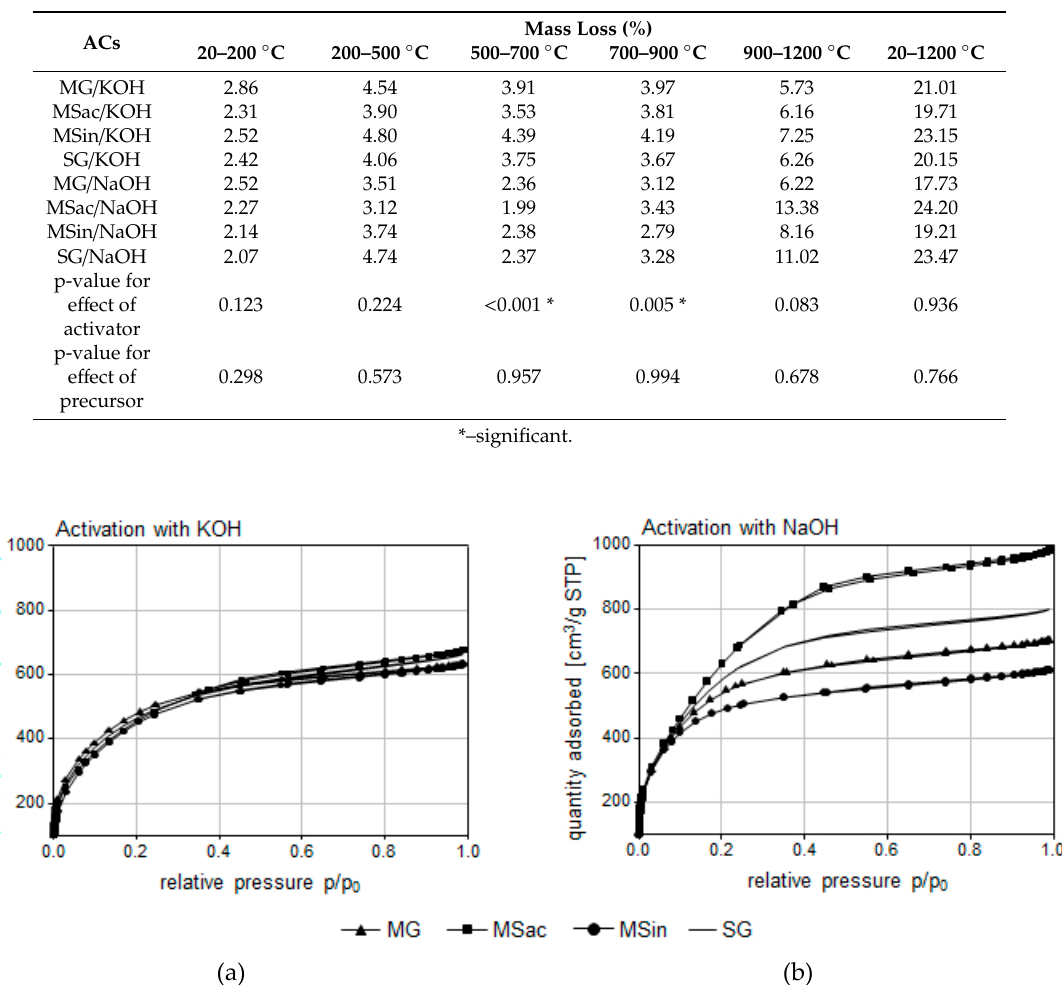
Table 6. Thermogravimetric analysis of activated carbons derived from miscanthus and switchgrass lignocellulosic raw materials.